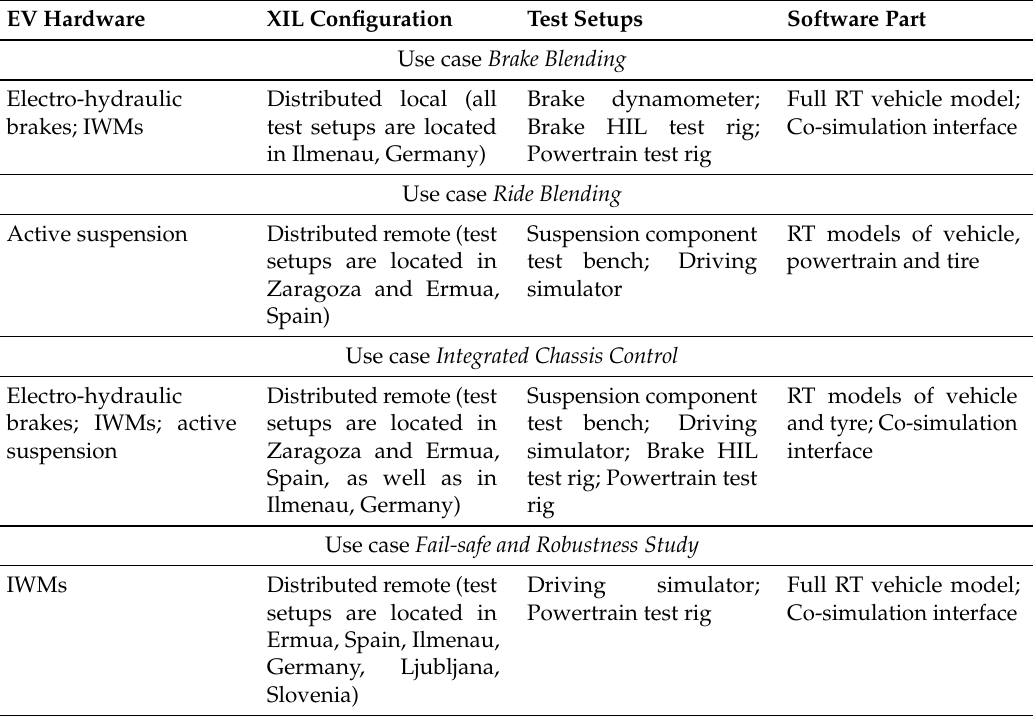
Table 1. XILforEV use